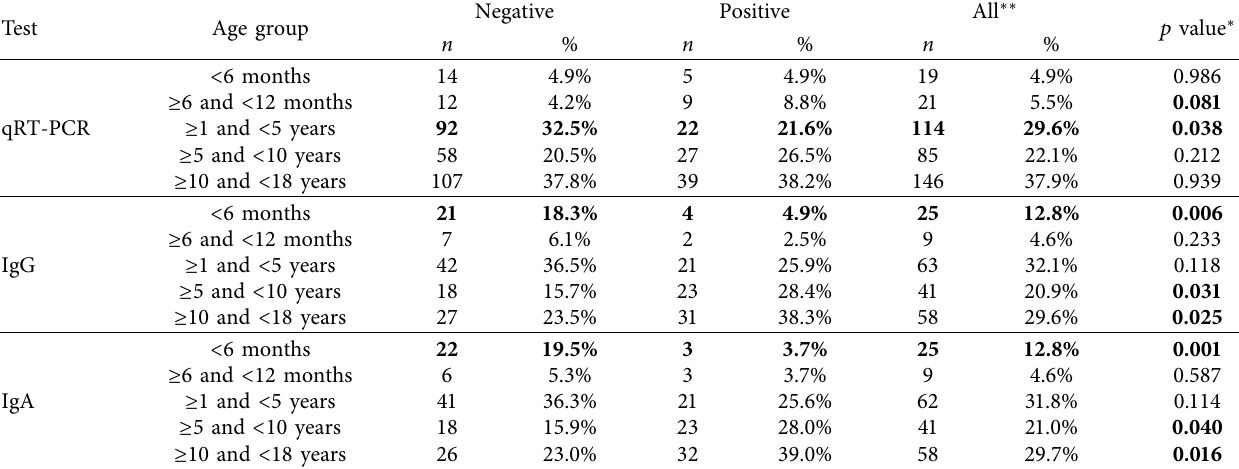
Table 6: Correlation between age and laboratory confirmation of SARS-CoV-2 in 385 ∗∗ children and adolescents.